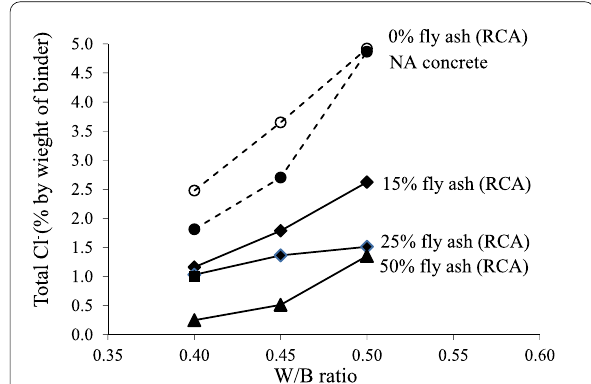
Fig. 4 Effect of W/B ratios on chloride content of NA and RCA concretes at the depth of 45 mm after 7-year exposure in a marine